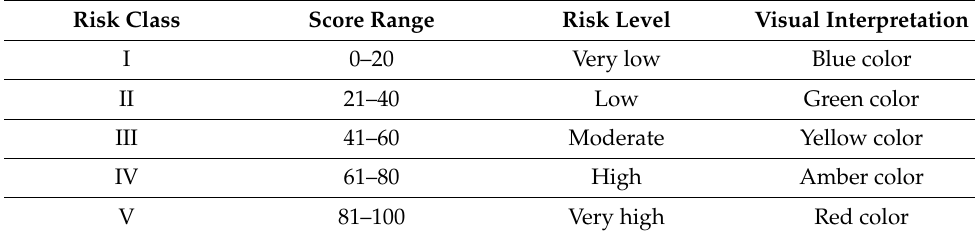
Table 9. Rockfall risk level classification based on the proposed rating